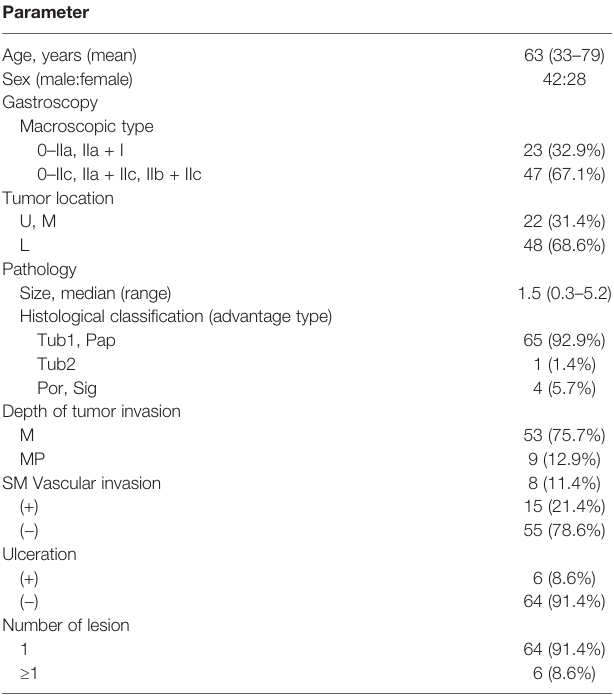
TABLE 1 | Clinicopathologic characteristics of patients (N = 70).